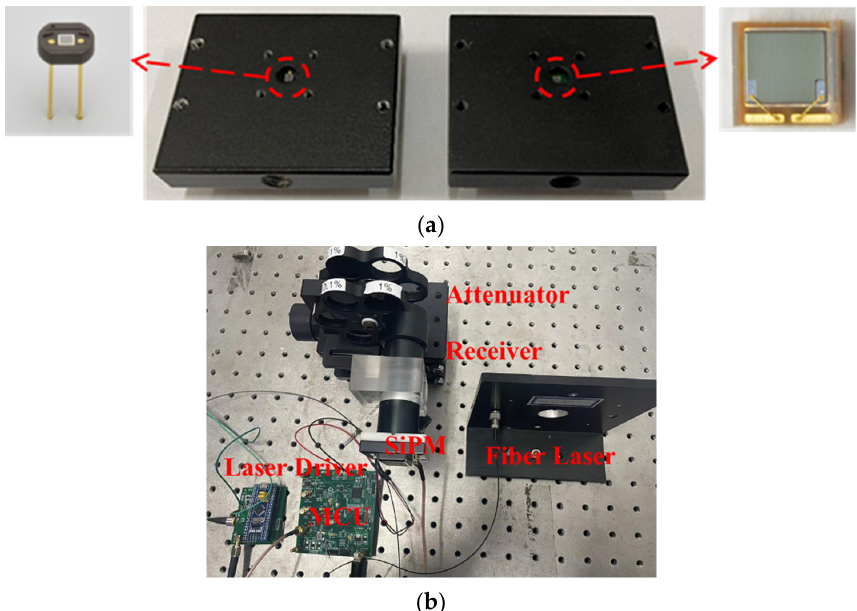
Figure A1. ( a ) The two SiPM modules with S13720-1325CS (left) and S15639-1325PS (right) inside. ( b ) Experimental platform.